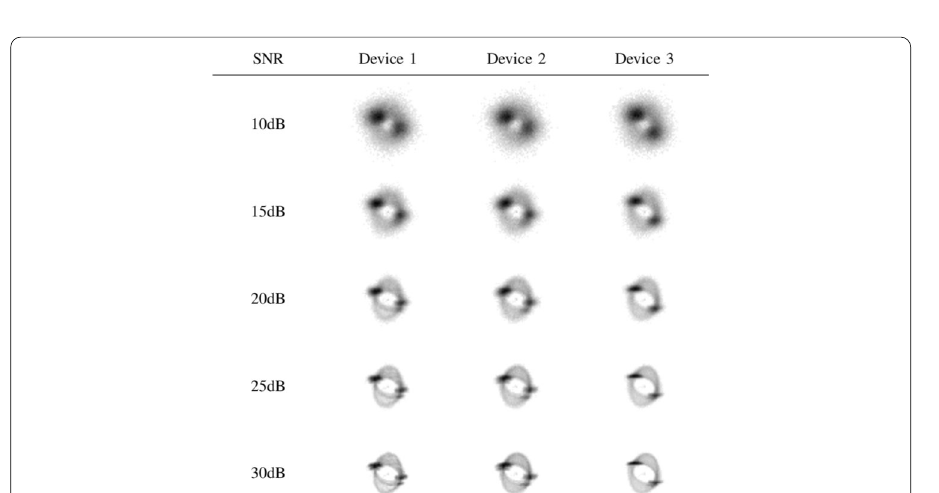
Fig. 7 DCTF extracted under different SNR environments. The DCTF images in different SNR scenarios are shown in these